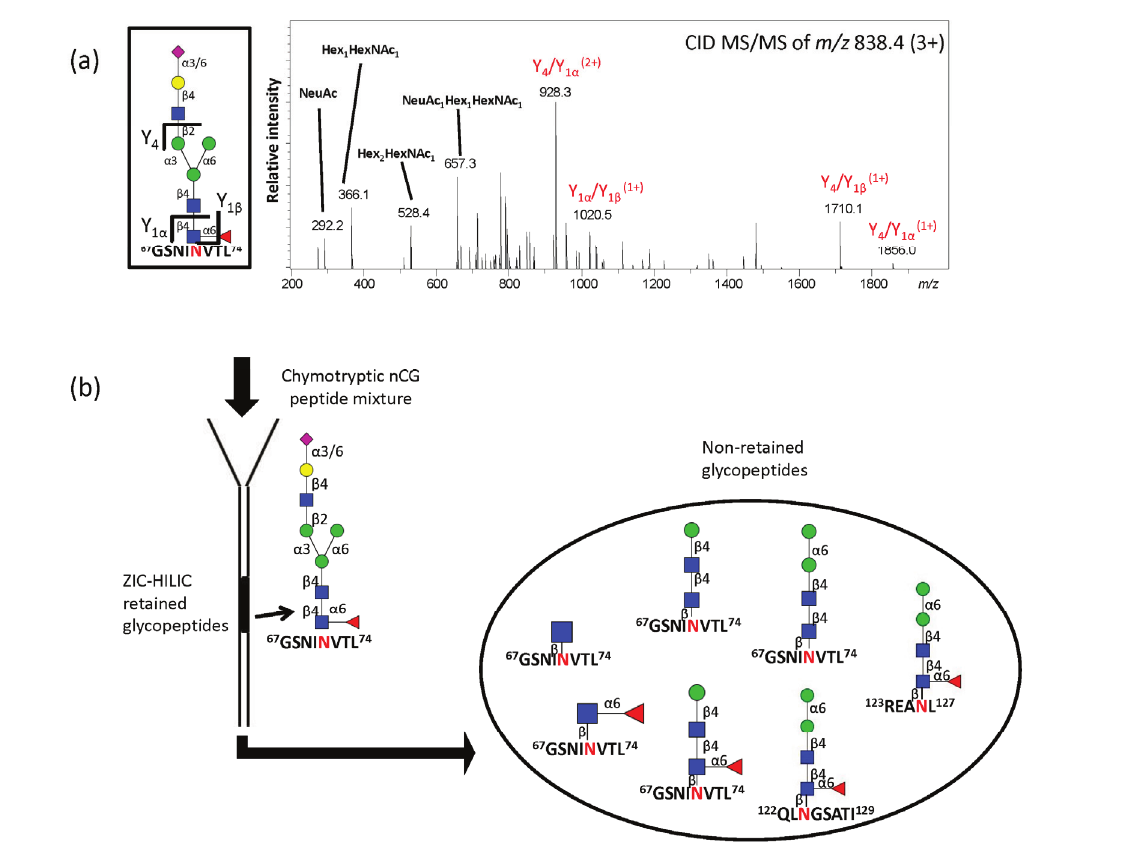
Figure 4. ( a ) RP-LC-CID-MS/MS confirming the structure of the single Asn71-glycopeptide of nCG retained on ZIC-HILIC SPE; ( b ) Schematic illustration showing the population of non-retained chymotryptic N -glycopeptides, i.e. , Asn71, Asn126, and